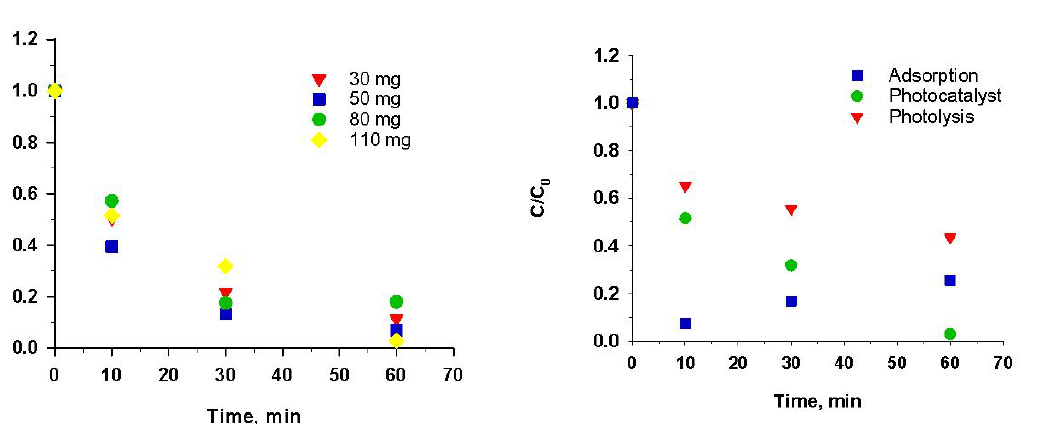
Fig. 10 MB removal efficiency using different amounts of Fe- ZIF-8 nanocatalyst. Reaction conditions: V= 50 ml, C pH=9.